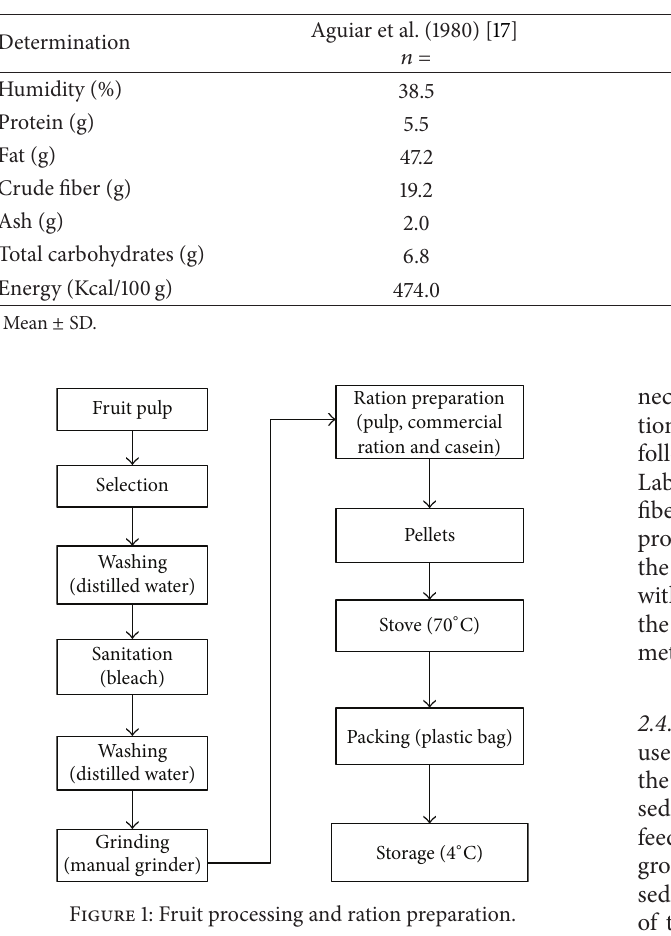
Table 1: Proximate composition of the tucum˜a fruit in natura .